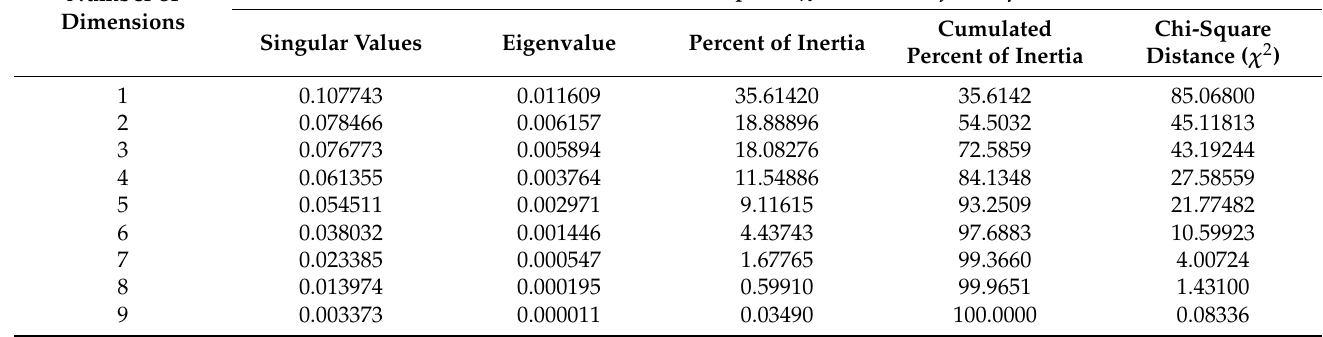
Table 3. Correspondence matrix characteristics for data in Table